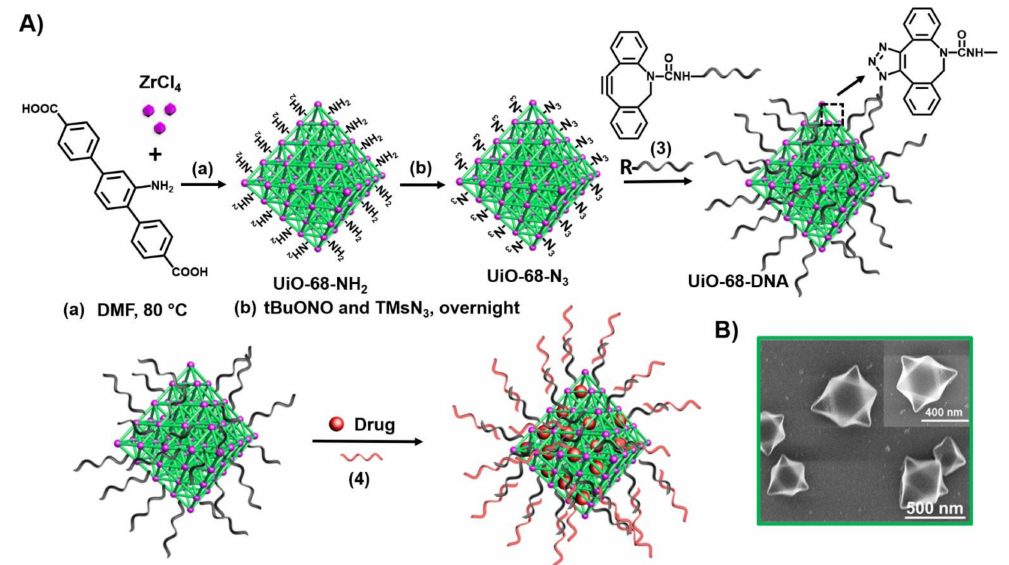
Figure 6. ( A ) Synthesis of nucleic acid-functionalized UiO-68 NMOFs loaded with a dye or a drug and locked by means of a stimuli-responsive strand ( 4 ). ( B ) SEM images of the nucleic acid-modified